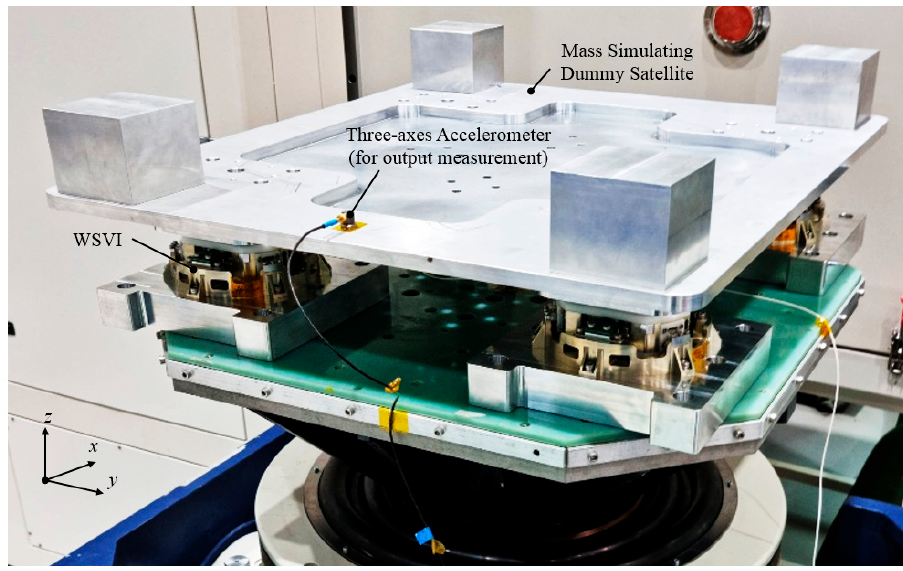
Figure 4. Example of the Launch Vibration Test Setup for the z -axis. Table 4. Specification of the Sine-vibration Test.